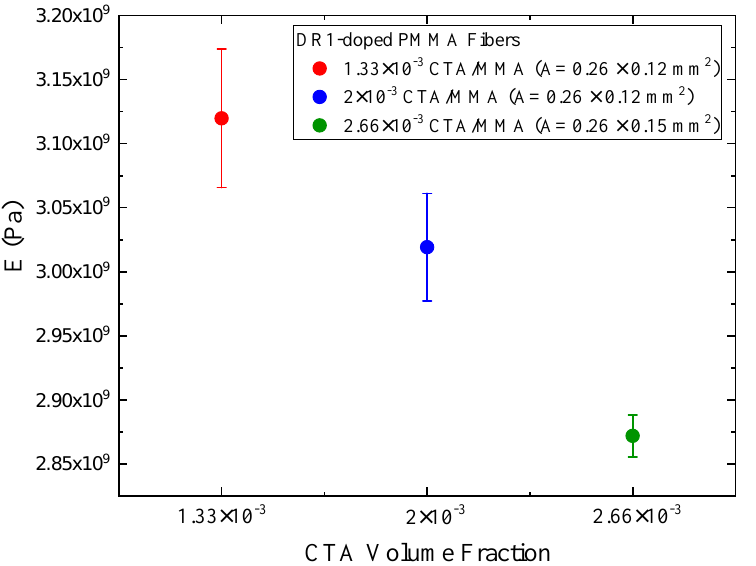
Figure 7. Measured Young’s modulus as a function of CTA volume fraction at room